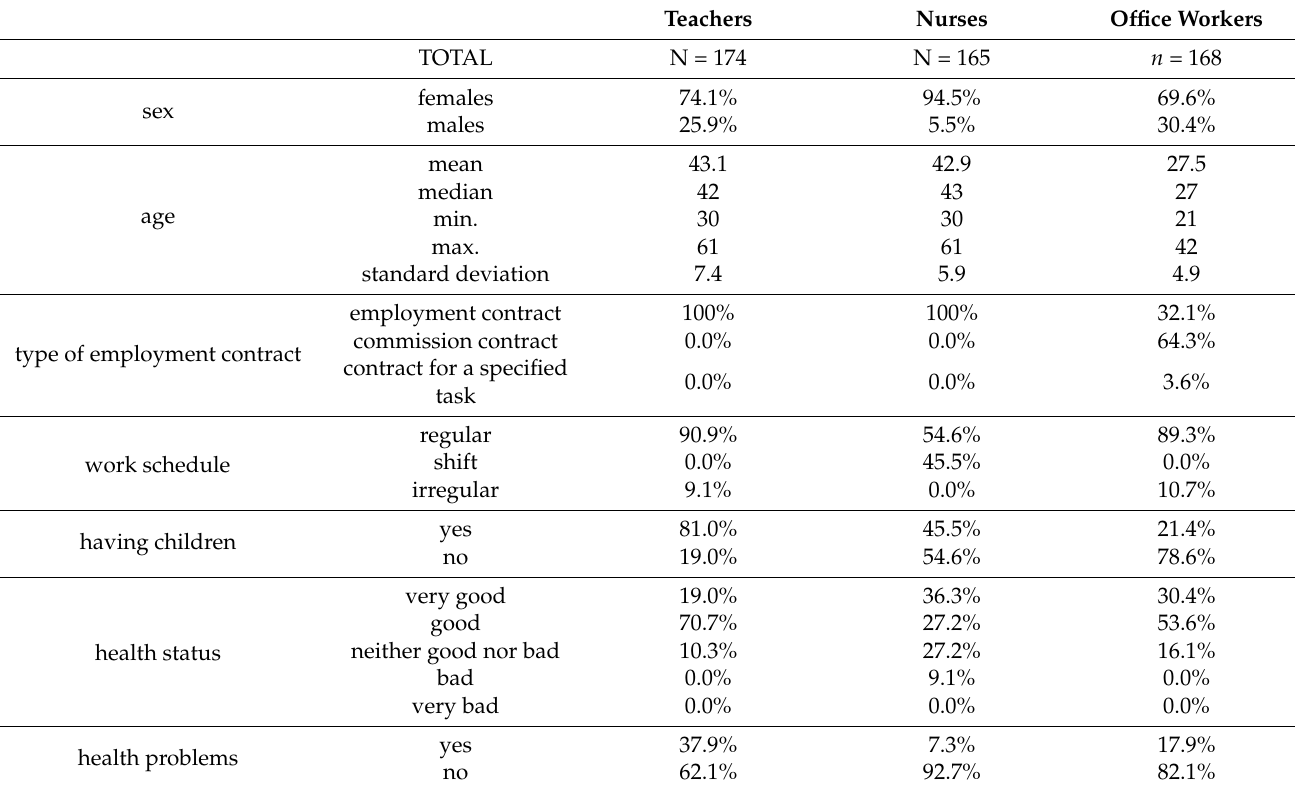
Table 1. Characteristics of